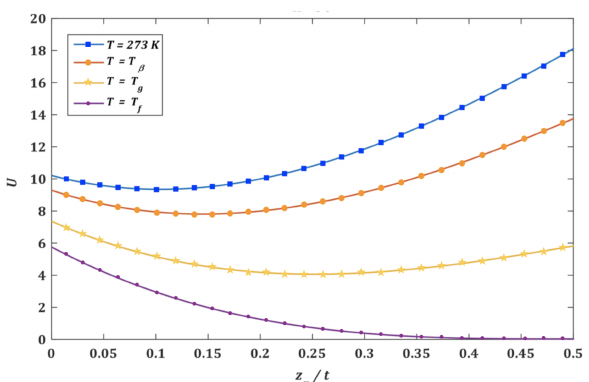
Figure 7: Variation of the strain energy with respect to z n / t for temperature from 273 to 373 K